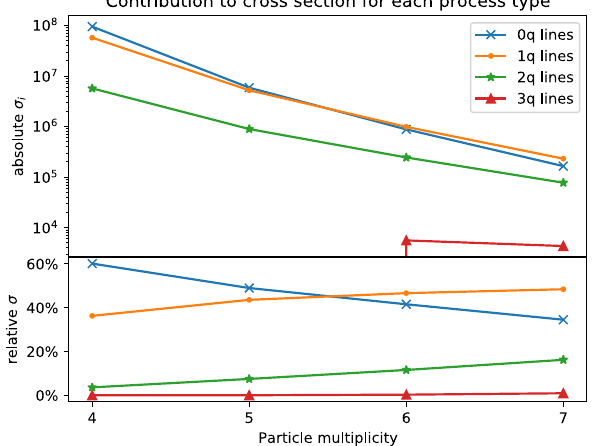
Fig. 17 MLM cross-section for each multiplicity and amplitude type without the inclusion of the Sudakov form-factor ( xqcut = 10 GeV )